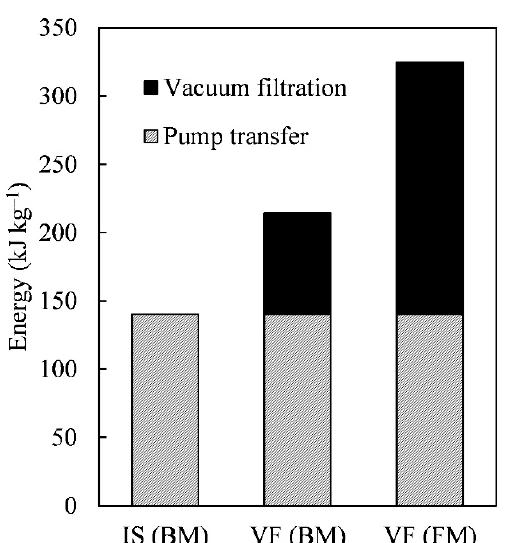
Figure 5. Input electrical energy per unit of dry algae in the algal harvesting from cultures in different media using an inclined solid–liquid separator (IS) or using vacuum filtration (VF). FM: Freshwater medium, BM: Brackish medium.